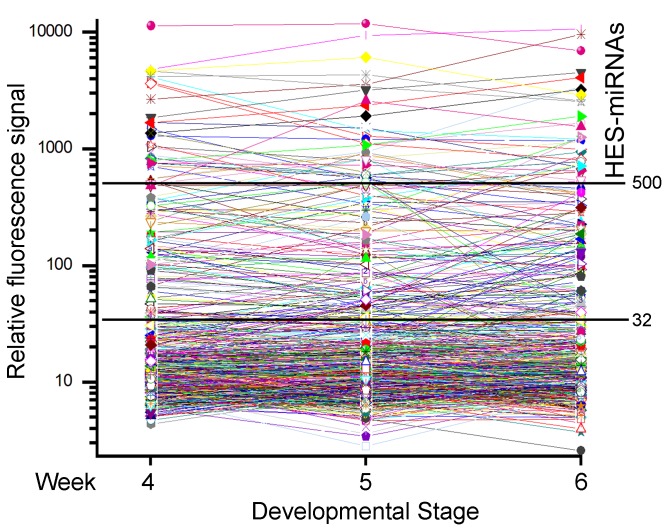
Expression overview of the 835 miRNAs during human embryonic developmentMiRNA expression levels during human embryonic development (weeks 4, 5, and 6 after fertilization) with signal strength greater 32 were considered as detected expression. A strong signal threshold of miRNA detection was defined as 500 after normalization. MiRNAs with a fluorescence signal greater than 500 at any stage at weeks 4, 5 or 6 were defined as HES-miRNAs.